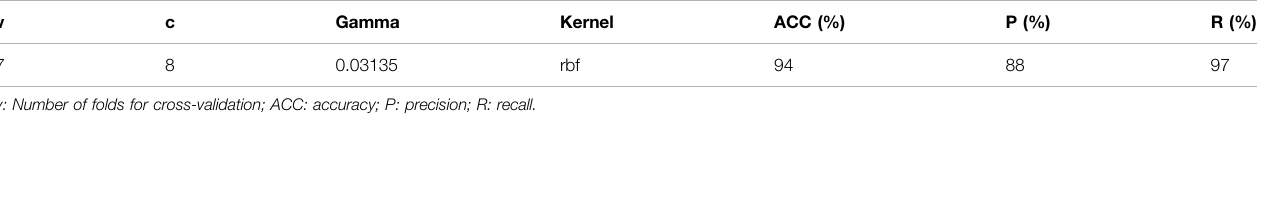
TABLE 5 | Screening results of active TCM ingredients based on SVM based prediction model.